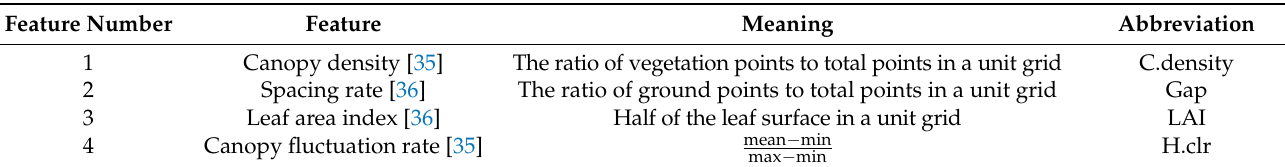
Table 4. Tree canopy features.